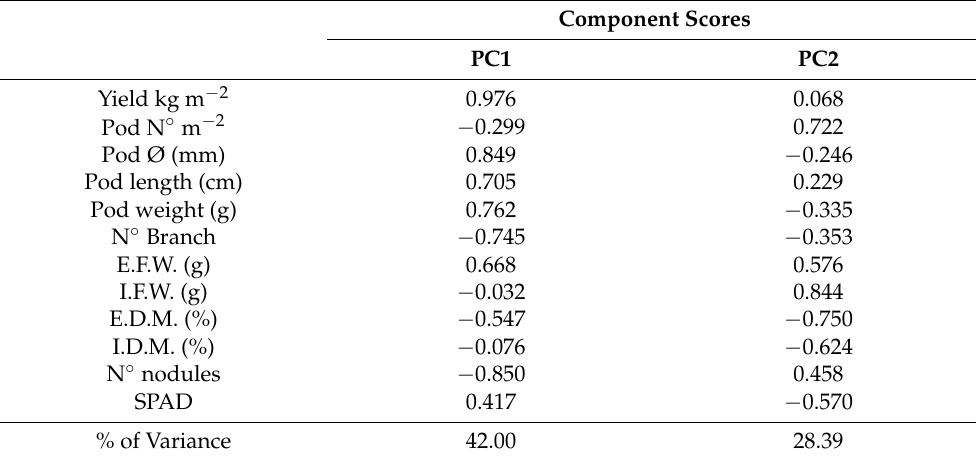
Figure 5. Two-dimensional principal component analysis (2D-PCA) that showed the characteristics analyzed. Table 4. PCs matrix related to the characteristics